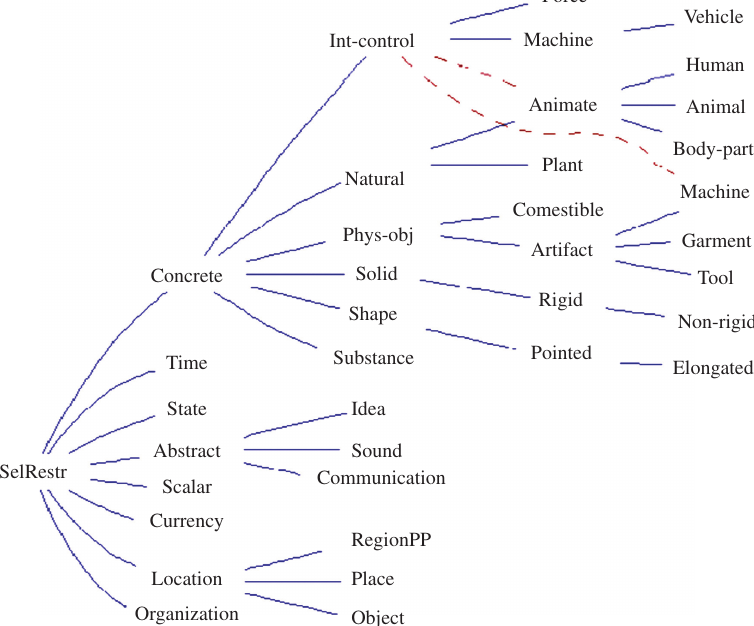
Figure 8: Selectional Restrictions Associated with Thematic Roles